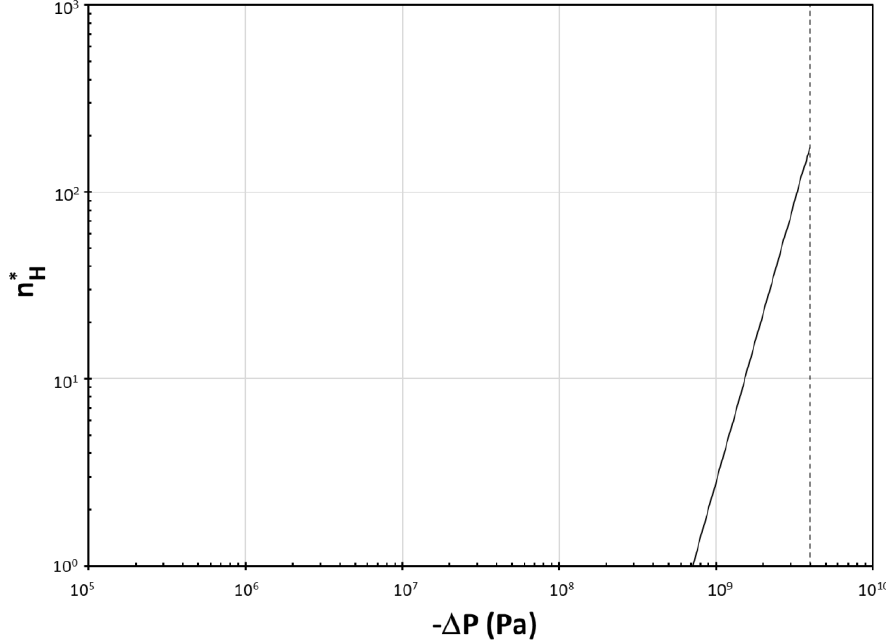
Figure 2. The change in number of hydrogen atoms needed in the critical nucleus with nucleation